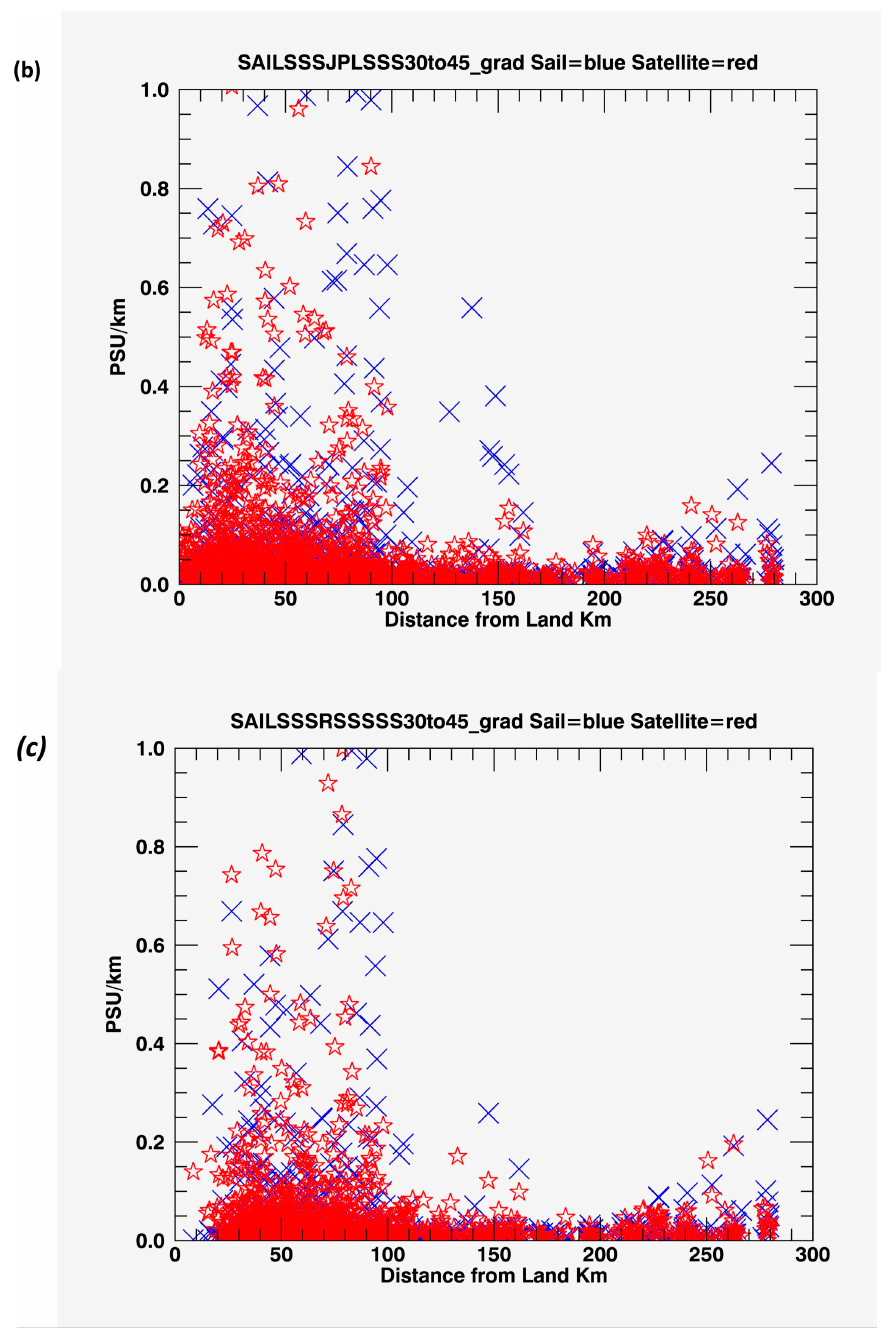
Figure 14. ( a – c ). Gradient magnitudes for ( a ) MURSST, ( b ) JPLSSS, and ( c ) RSSSSS versus distance from land. Blue Xs indicate Saildrone and red stars indicate satellite (MURSST, JPLSSS, RSSSSS). The application of the wavelet analysis indicates that fronts, identified based on gradients, are associated with known centers of upwelling. High correlations over the entire region of study between the MURSST gradients and Saildrone SSTs gradients validate their location and thus fronts in the region, indicating that they are resolving the features associated with coastal upwelling. Correlations of <0.20 for the JPLSSS and the RSSSSS are significantly lower for the region between 32 ◦ N to 33 ◦ N. This is consistent with the wavelet analysis in Figures 8 and 11, showing significantly reduced wavelet spectra of the gradients near the coast. This is also the region which is closest to the coast (see Figures 3 and 4)